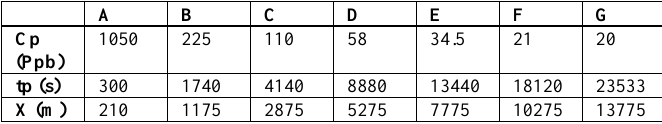
Table 1: Main data on 7 tracer experiments in River Severn.